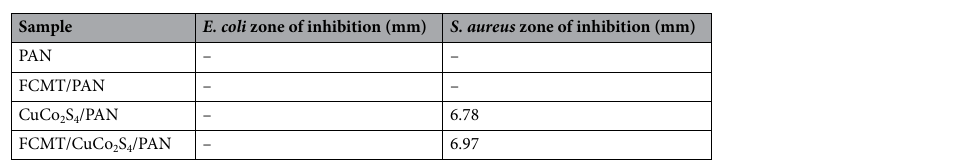
Figure 7. Antibacterial activity of PAN, FCMT/PAN, CuCo 2 S 4 /PAN, and FCMT/CuCo 2 S 4 /PAN against E. coli and S. aureus.